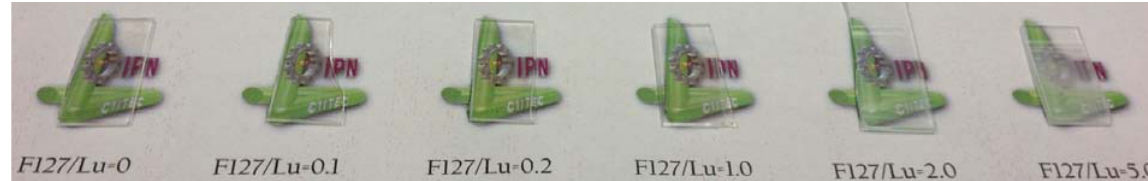
O :Eu 3+ F127 modified thin films. 2 3